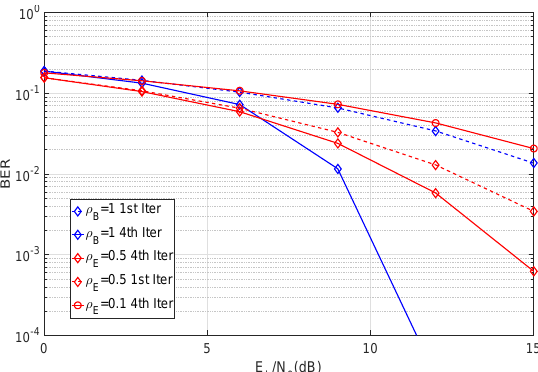
Figure 4. Comparison of BER for different values of ρ E , with β N = β M = ∞ .